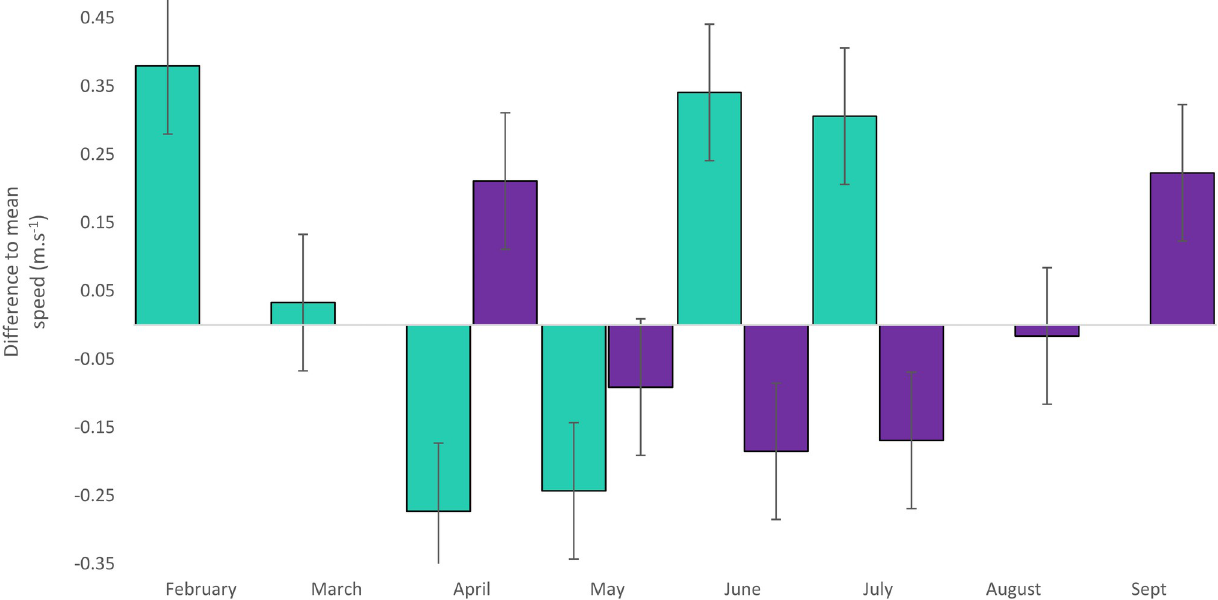
Fig 4. Monthly anomalies from trip speed for tracked Fiordland penguins and Snares penguins over the non-breeding season. The Fiordland penguin migration takes place from February to July, while the Snares penguin migration takes place from April to September. Mean individual travelling speeds were 0.57 ± 0.4 m.s -1 and 0.63 ± 0.4 m.s -1 for Fiordland penguins and Snares penguins, respectively. Fiordland penguins had the slowest speeds during the months of April and May, and Snares penguins during the months of June and